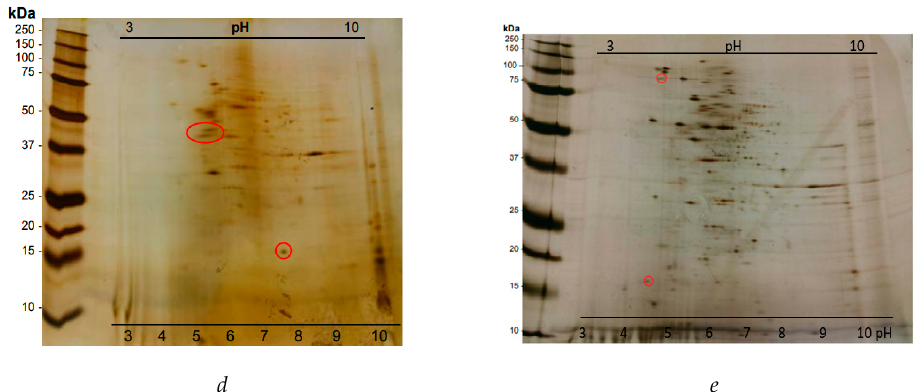
Figure 5. Two-dimensional analysis (IEF / SDS-PAGE R) of lectin-bound proteins of HT29 cell membrane. ( a ) Two-dimensional electrophoresis of the HT29 cell membrane control, 1 mg of membrane protein was applied. ( b )Two-dimensional electrophoresis of the total protein extract of Juniperus oxycedrus subsp. Oxycedrus, ( c ), Juniperus oxycedrus subsp . badia, ( d ) Arbutus unedo and ( e ) Corema album , obtained after incubation with 1 mg of HT29 cell membrane with 1.6 mg protein extract and applied to a 17.5% ( w / v ) gel of acrylamide, stained by AgNO 3 .